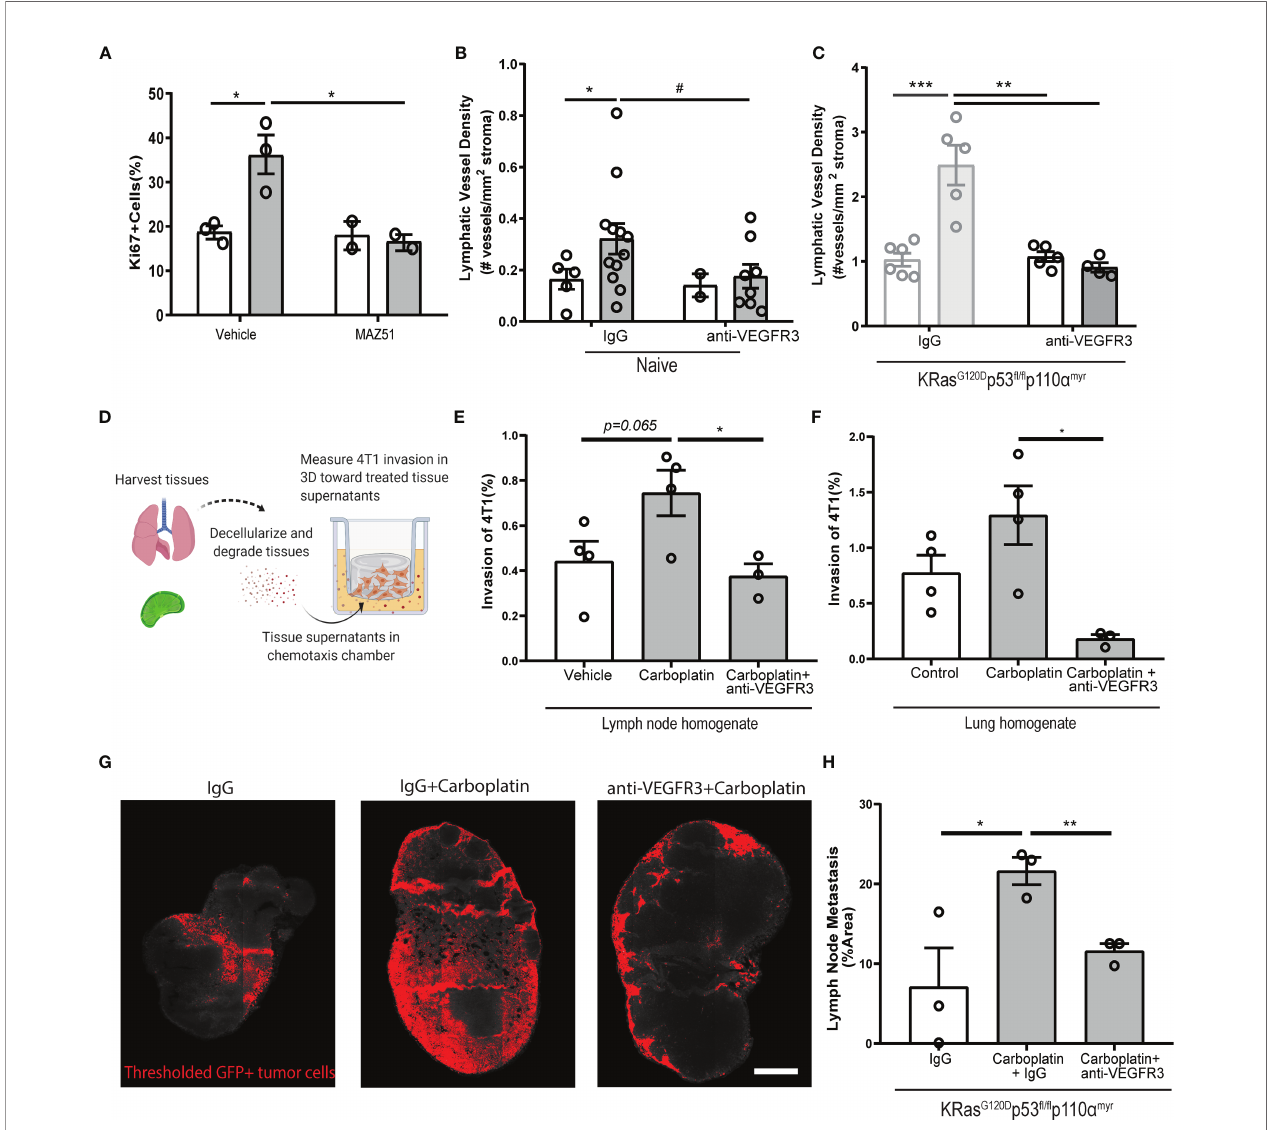
FIGURE 6 | Blockade of VEGFR3 inhibits carboplatin-induced lymphangiogenesis and metastasis (A) Percent proliferating cells per fi eld by Ki67+ staining of human LEC monolayers treated in vitro with carboplatin (1 µM), VEGFR3 inhibitor MAZ51 (1 µM), or both for 6h (n=2-3/group; data points represent independent experiments). (B) Lymphatic vessel density in naïve, tumor-free fat pads from mice treated with vehicle/carboplatin and anti-VEGFR3/IgG (N=27; one data point per mouse). (C) Lymphatic vessel density (lymphatic vessels per stromal area) in tumor-bearing fat pad of KRas G120D p53 fl / fl p110 a myr mice treated vehicle/carboplatin and anti- VEGFR3/IgG. Grayed bars represent data presented in previous fi gure but included here as point of reference. (N=21; one data point per mouse). (D) Experimental schematic of chemotaxis assay using digested and decellularized in vivo -treated tissues. Healthy, tumor-free mice were treated in vivo with carboplatin (8 mg/kg x 3 or vehicle) and/or anti-VEGFR3 antibody (or control IgG antibody). Lymph nodes and lungs were harvested 3 days following fi nal treatment, digested and decellularized, and used in a 3D in vitro chemotaxis assay for 4T1 cells. (E, F) Invasion of 4T1 tumor cells towards digested and decellularized lymph node (E) and lung (F) from treated mice (n=3-4/group; each data point represents extract from one mouse, as average of 3 independent in vitro experiments). (G) Representative thresholded images and (H) quanti fi cation GFP+ tumor cells in whole inguinal lymph nodes from KRas G120D p53 fl / fl p110 a myr mice treated with vehicle/carboplatin and anti-VEGFR3/IgG (n=3/group; one data point per mouse). # p < 0.1, *p < 0.05, **p < 0.01, ***p <